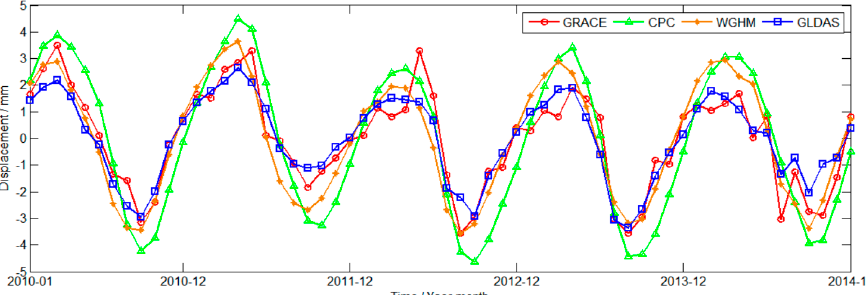
Figure 2. The crustal vertical deformation in SGN region driven by terrestrial water load represented by GRACE and three hydrological models from 2010 to